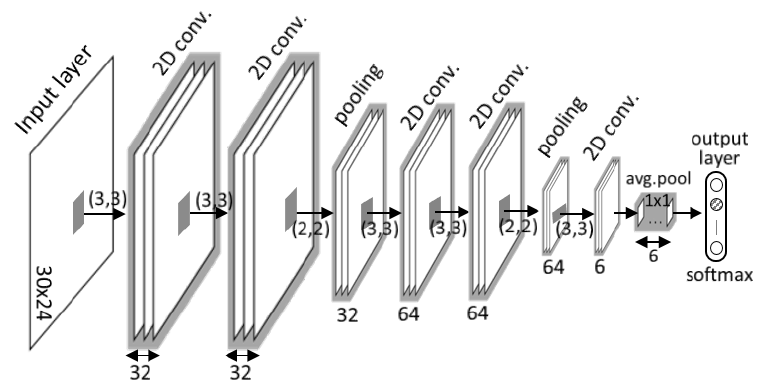
Figure 4. Example architecture of fully convolutional networks for classifying activities